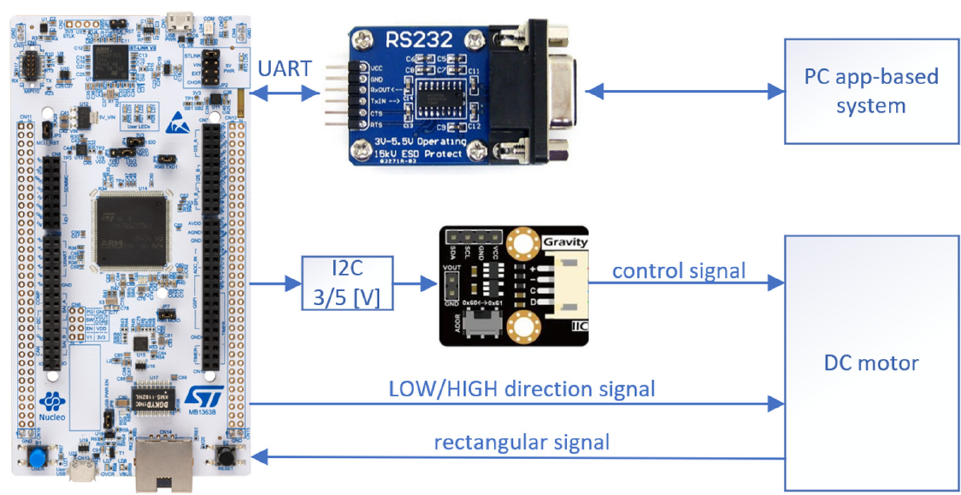
Figure 6. Scheme of connections between microcontroller and peripheral modules.